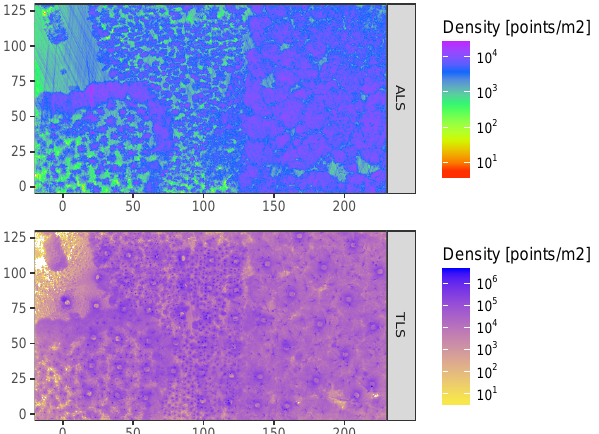
Figure 4. ALS and TLS point cloud density maps for whole study site at 0.5m resolution in project coordinate